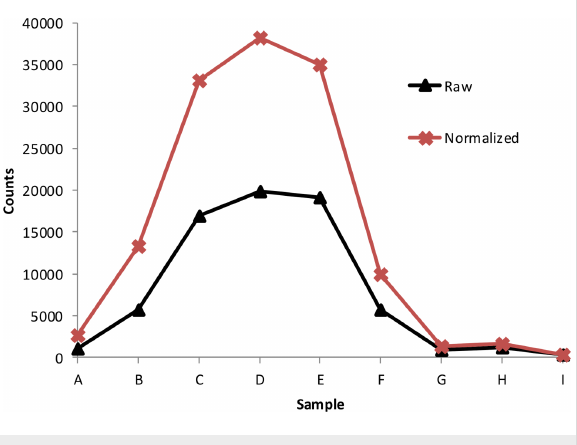
Figure 5: SERS signal of 1080 cm − 1 band measured on SSFs A–I (Raw) and normalized by their metal coverage